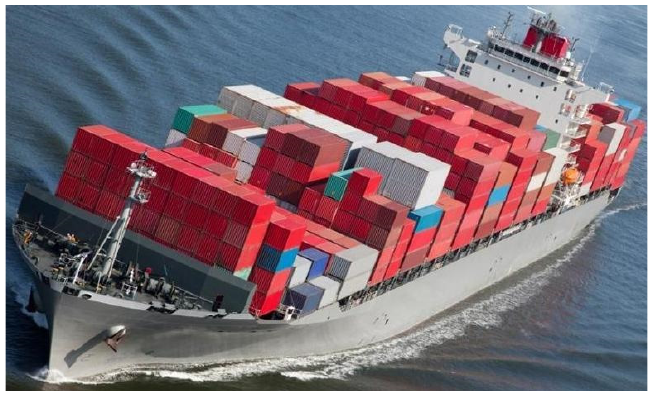
Figure 2. Original image of ship.